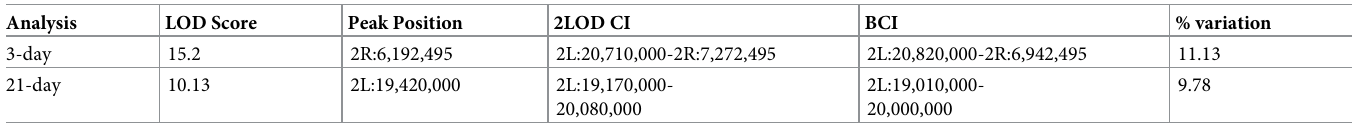
Table 1. QTL positions in 3 and 21-day old females. The peak position, Δ 2LOD drop confidence interval (2LOD CI), and the Bayesian Credible Interval (BCI) in dm6 [29] are provided for each analysis. The data used to identify the LOD peaks and intervals for 3 and 21-day old females can be found in S3 and S4 Tables , respectively.